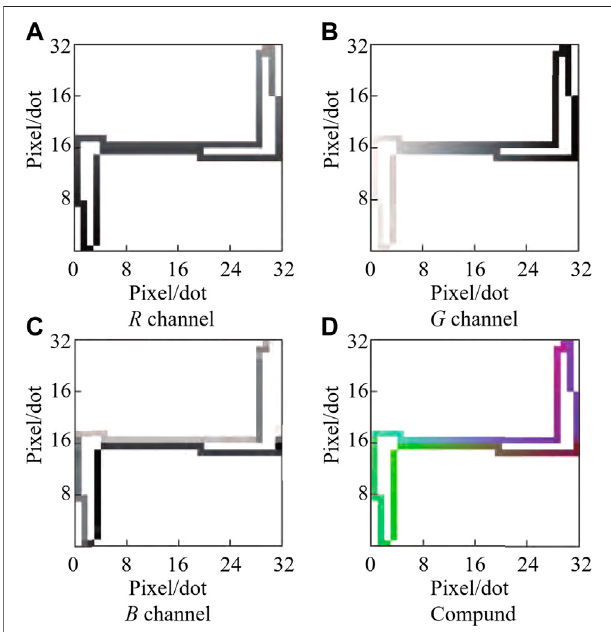
FIGURE 2 | Image of each channel of a fl uorescent lamp and the synthesized V-I color